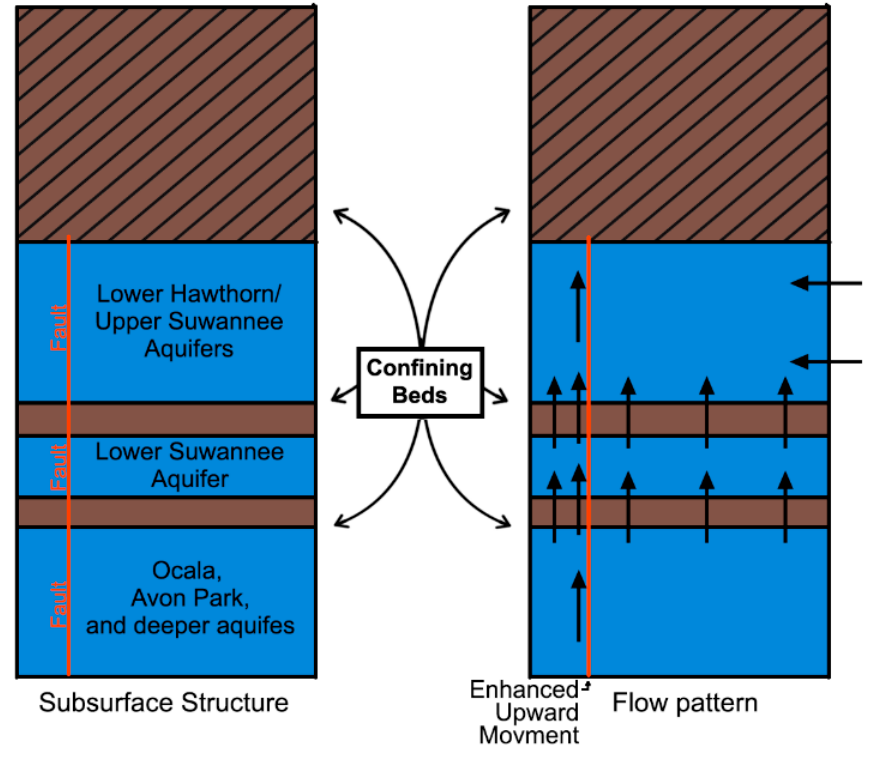
Figure 16. New conceptual model for the City of Cape Coral wellfield.